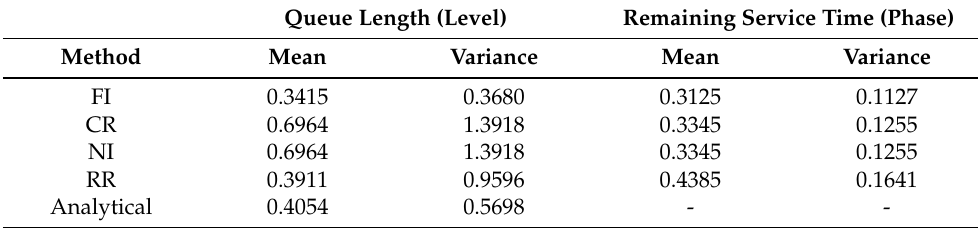
Table 1. Mean and variance of level and